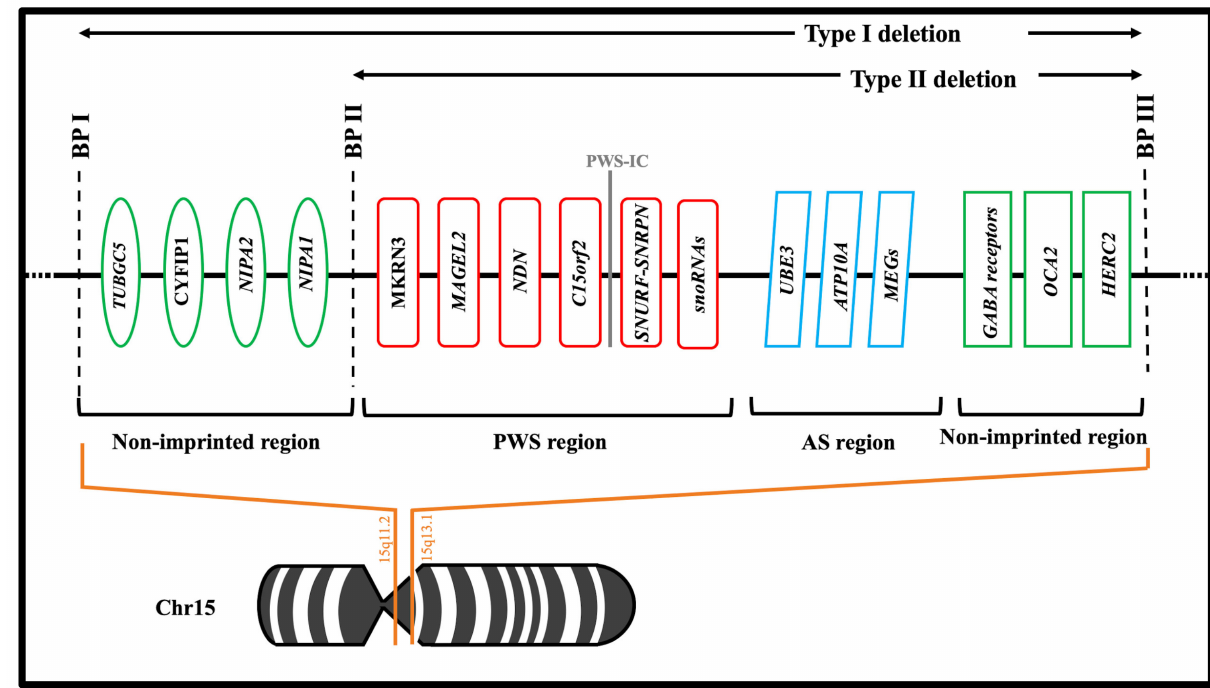
Figure 1. The Ideogram of Chromosome 15q11-q13 showing main genes in PWS located in the typical deletion region of Prader-Willi syndrome. BP, breakpoint; PWS, Prader-Willi syndrome; PWS-IC, Prader-Willi syndrome-imprinting center; AS, Angelman Syndrome. Green Ovals and Rectangles: Biallelic expression; Red Rounded rectangles: Paternal expression; Light Blue Parallelograms: Maternal expression. Adapted from Cheon et al.